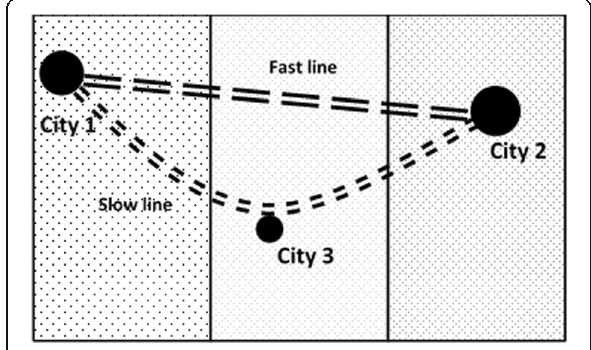
Fig. 1 The assessed desirability of the the alternatives depends on the perspective and scope of evaluation. Figure by